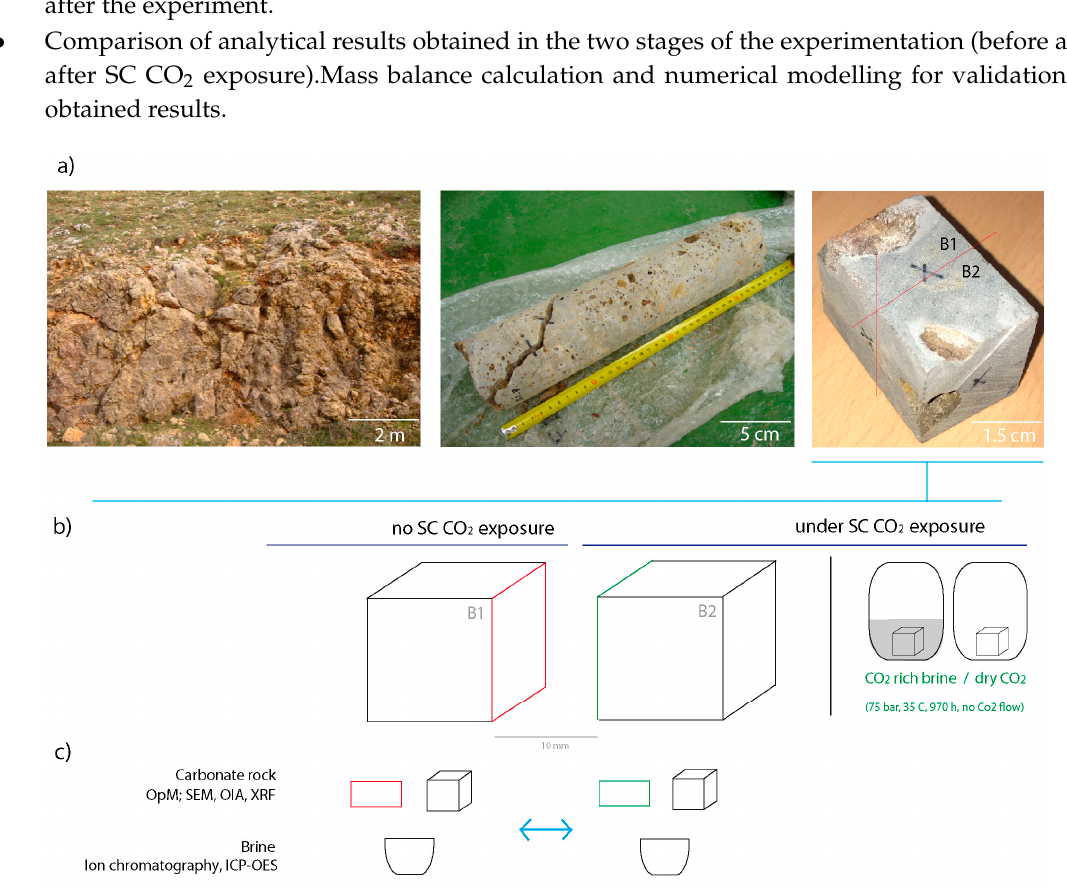
Figure 2. Process of sampling ( a ) and sample preparation ( b ) for mineralogical and geochemical analyses before and after SC CO 2 exposure ( c ).